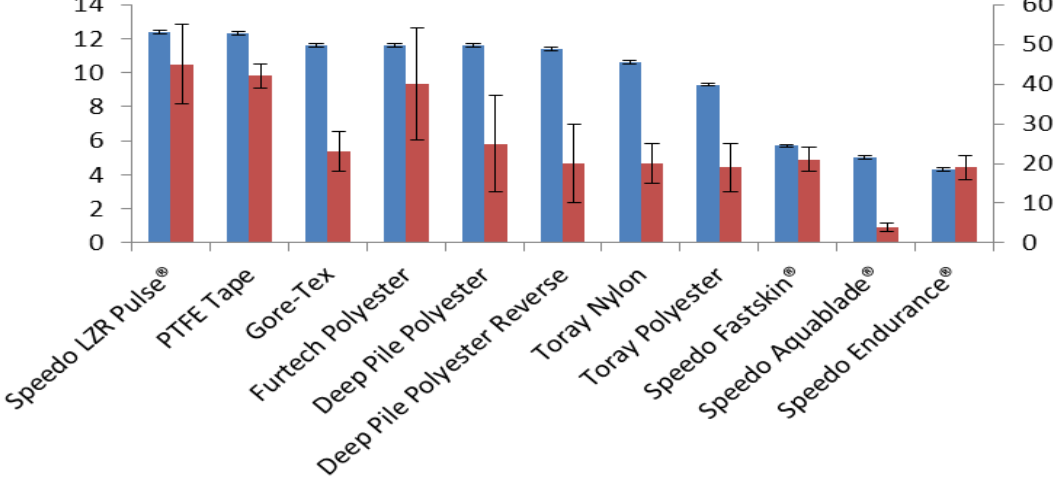
Figure 6. The %O in the fabric boxes after 6 h (blue bar and left y -axis) and Plastron 2 coverage/(Density × Thickness) (red bar and right y -axis) of the